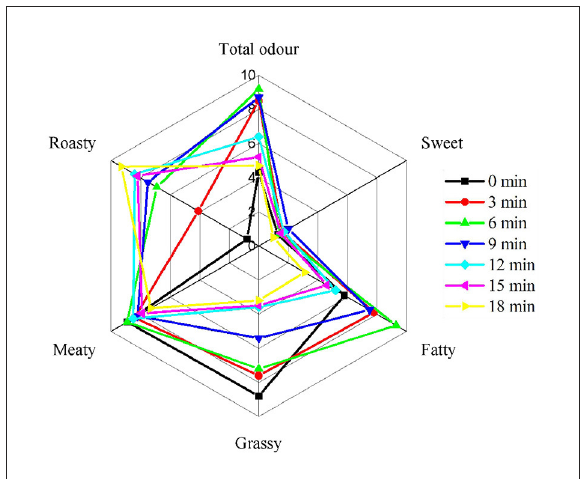
FIGURE1 Flavor profiles of roasted beef samples by sensory